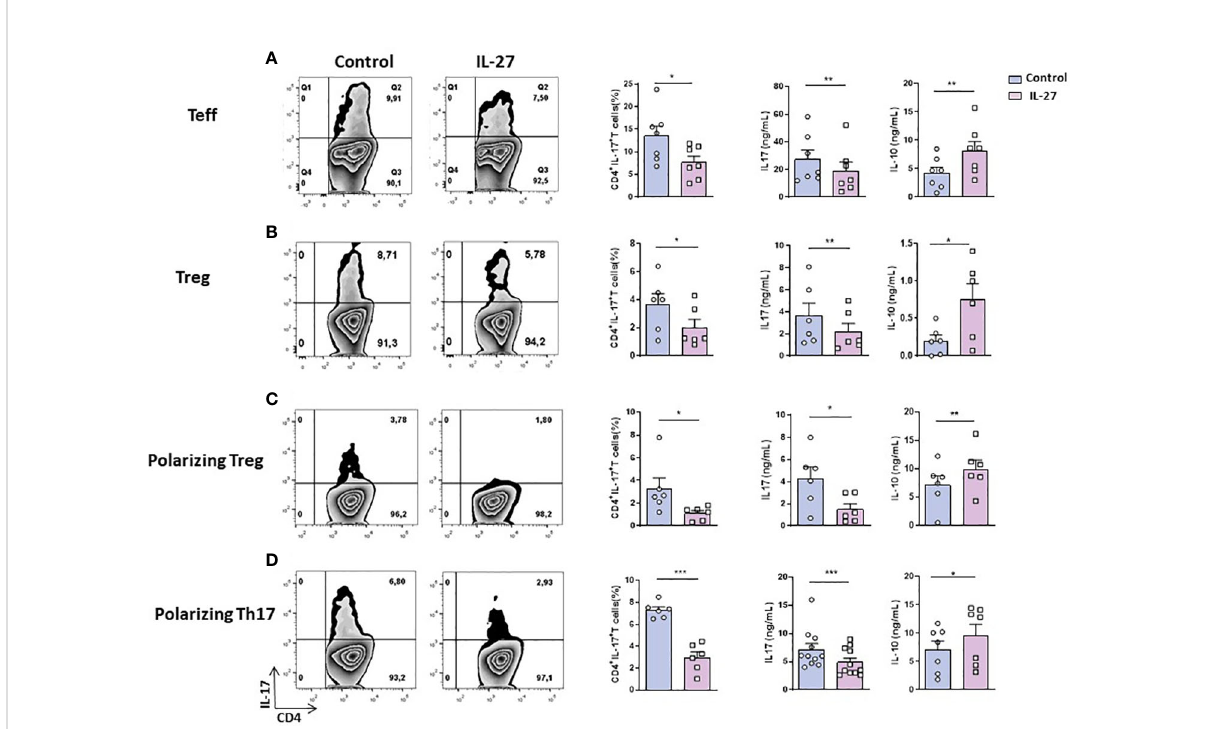
FIGURE 1 IL-27 effect on the generation/maintenance of IL-17-producing T cells. (A) Ex vivo sorted resting Teff cells (CD4 + CD25 - CD62L - or (B) ex vivo sorted Treg (CD4 + CD25 high ) from B27-rats aged of 3-5 months were cocultured with CD103 + DCs for 3 days; (C, D) ex vivo sorted naïve (CD4 + CD25 - CD62L + ) T cells were cocultured with CD103 + DCs for 6 days in (C) Treg (TGF- b ) or (D) Th 17 (TGF- b + IL-6 + IL-1 b + IL-23) polarizing conditions. Left panels show representative fl ow cytometry dot plots evaluating the percentage of IL-17-producing CD4 + T cells after coculture and the mean + SEM of 6-11 rats/group; right panels show the mean + SEM of IL-17 and IL-10 levels that were evaluated in the supernatant of cocultures by ELISA. *p < 0.05; **p < 0.01 ; ***p =